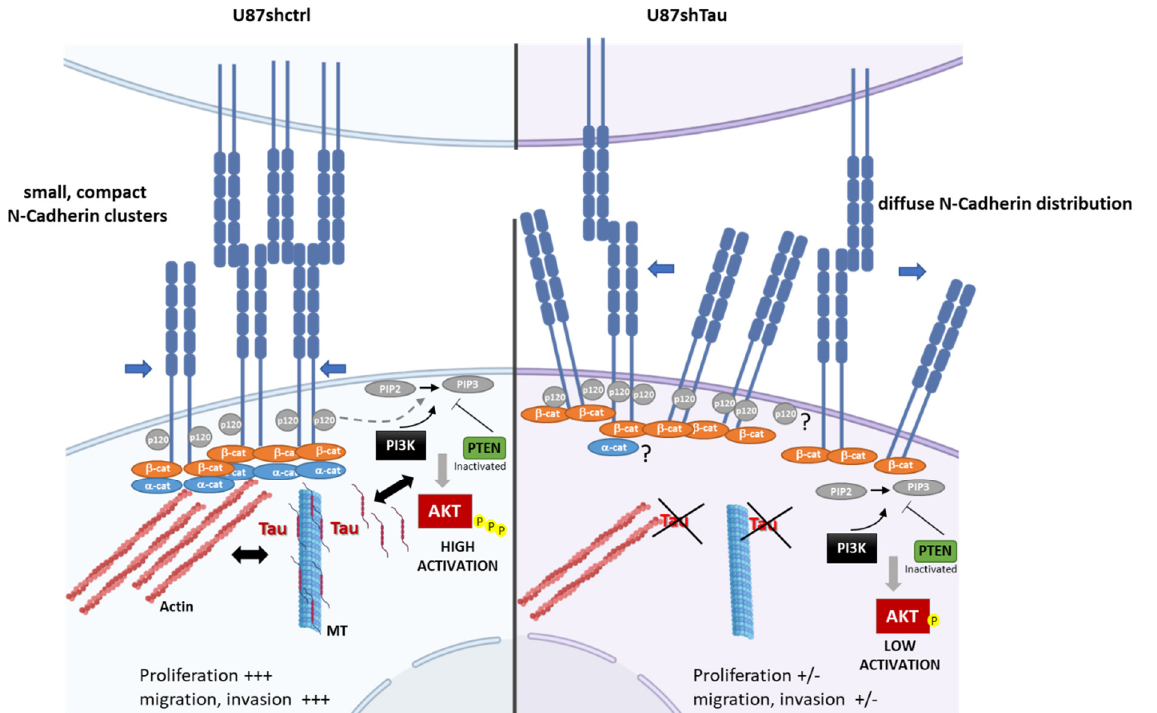
Figure 8. Proposed model for the role of Tau in controlling 3D N-cadherin-dependent cell cohesion and PI3K/AKT signaling axis. Left part: In the context of PTEN -null mutated GBM, Tau may contribute by MT-dependent function and MT-actin crosstalk to stabilize the N-cadherin- β -catenin complexes. This induces the formation of compact N-cadherin clusters reinforcing cell–cell interactions. Tau may also contribute to PI3K-AKT activation either by MT-independent interactions (direct?) or through increased N-cadherin- β -catenin signaling (indirect?). This will promote cell proliferation and invasion. Right part: In Tau-depleted cells (U87shTau), N-cadherin- β -catenin complexes recruitment to the actin cytoskeleton is defective, and N-cadherin is not stabilized at the membrane resulting in loss of compact N-cadherin clusters organization. Mislocalized N-cadherin may sequester β -catenin, which will be responsible for the loss of cell–cell cohesion, spheroid compactness and decreased PI3K-AKT signaling activity. This will result in the inhibition of cell proliferation and migration. ABBREVIATION: β -cat: β -catenin; α -cat: α -catenin; PIP-2: phosphatidyl-inositol 4,5; PIP3: phosphatidylinositol-3,4,5- trisphosphate PTEN: Phosphatase and TENsin homolog. p120, α -cat?: remains to be